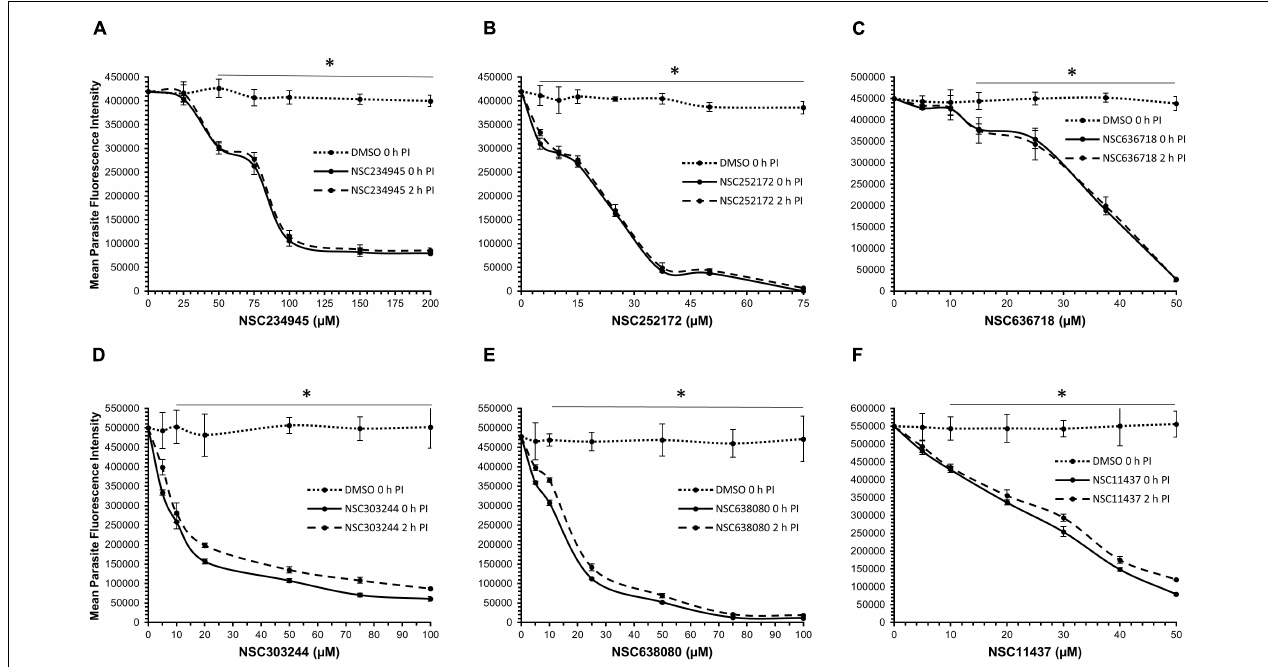
FIGURE 5 | Effect of varying concentrations of rCpPyK inhibitors on the growth of C. parvum in HCT-8 cells. Equal amounts of freshly excysted sporozoites of C. parvum were inoculated into HCT-8 cells in culture and varying concentrations of (A) NSC234945, (B) NSC252172, (C) NSC636718, (D) NSC303244, (E) NSC638080, and (F) NSC11437 were added at the time of infection (solid line) or added 2 h post-infection (PI) (dashed line). Control infected cells (dotted line) were treated immediately PI with volumes of DMSO equivalent to those used in the compound-treated cultures. After 48 h, the cultures were analyzed for parasite proliferation by immunofluorescence assays. The fluorescence generated by intracellular C. parvum merozoites was quantified and is shown on the Y -axis representing the parasite load. The data shown represent the mean of three independent experiments. Bars represent standard errors of the mean (SEM) with level of statistical significance as compared to the DMSO-treated controls indicated by asterisk ( ∗ P < 0.05).